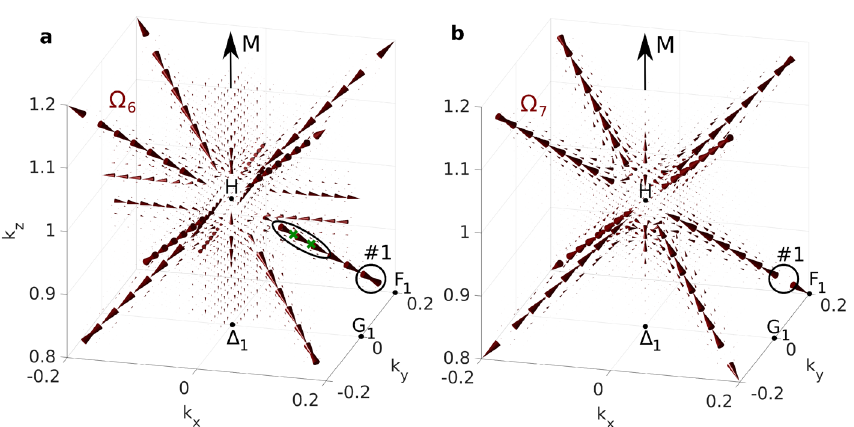
Figure 2. Flow of the Berry curvature vector field. Berry curvature of ( a ), band 6 and ( b ), band 7 in a cube centered at point H. All relevant features are highlighted and relate to Fig. 1. The size of the largest cone is 2 3500 bohr . Cone size cutoff was performed as in the vicinity of monopole sources the magnitude of the Berry curvature is very